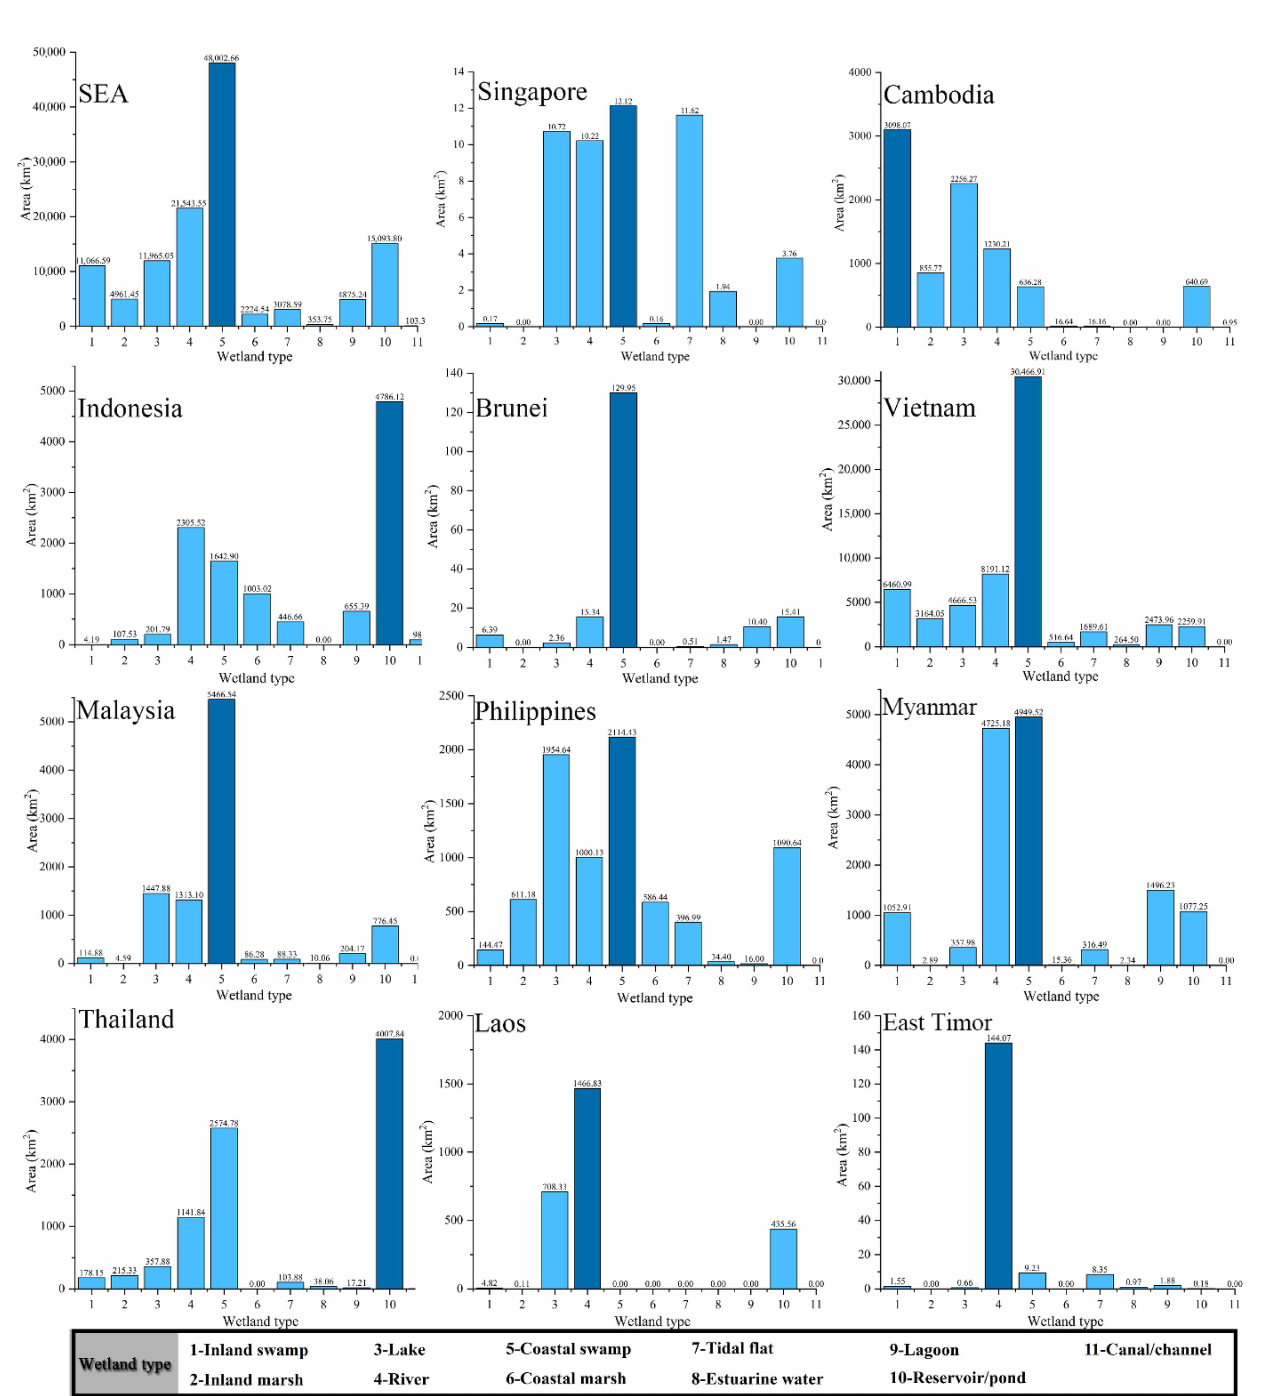
Figure 11. The wetlands statistics data of each country in Southeast Asia from the SEAWeC,